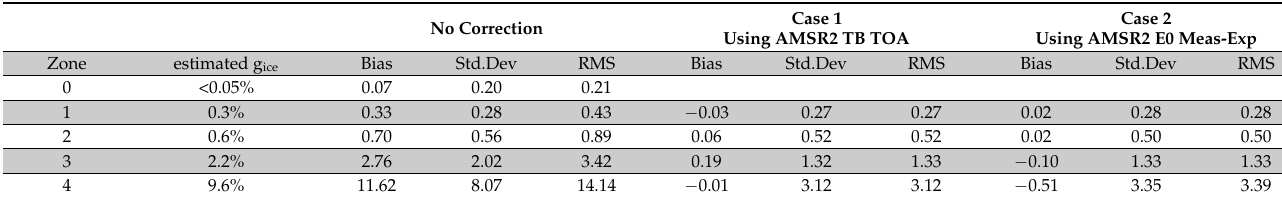
Table 5. Performance statistics of the sea-ice correction algorithm (Section 2.4) for the test set (Table 1) within sea-ice zones 0–4. The table lists biases, standard deviations and RMS (all in K) for the performance metric, which is the SMAP V-pol specular surface TB bias ∆ T B,0 (SMAP V). Case 1 refers to the algorithm using the AMSR2 TOA as input. Case 2 refers to the algorithm using the AMSR2 measured minus expected specular surface emissivities as input. The estimated average g ice values in the 2nd column are obtained by dividing the values for the TB biases without correction in each zone by 125 K, which is a typical value for the L-band TB difference between sea-ice and ocean scenes.